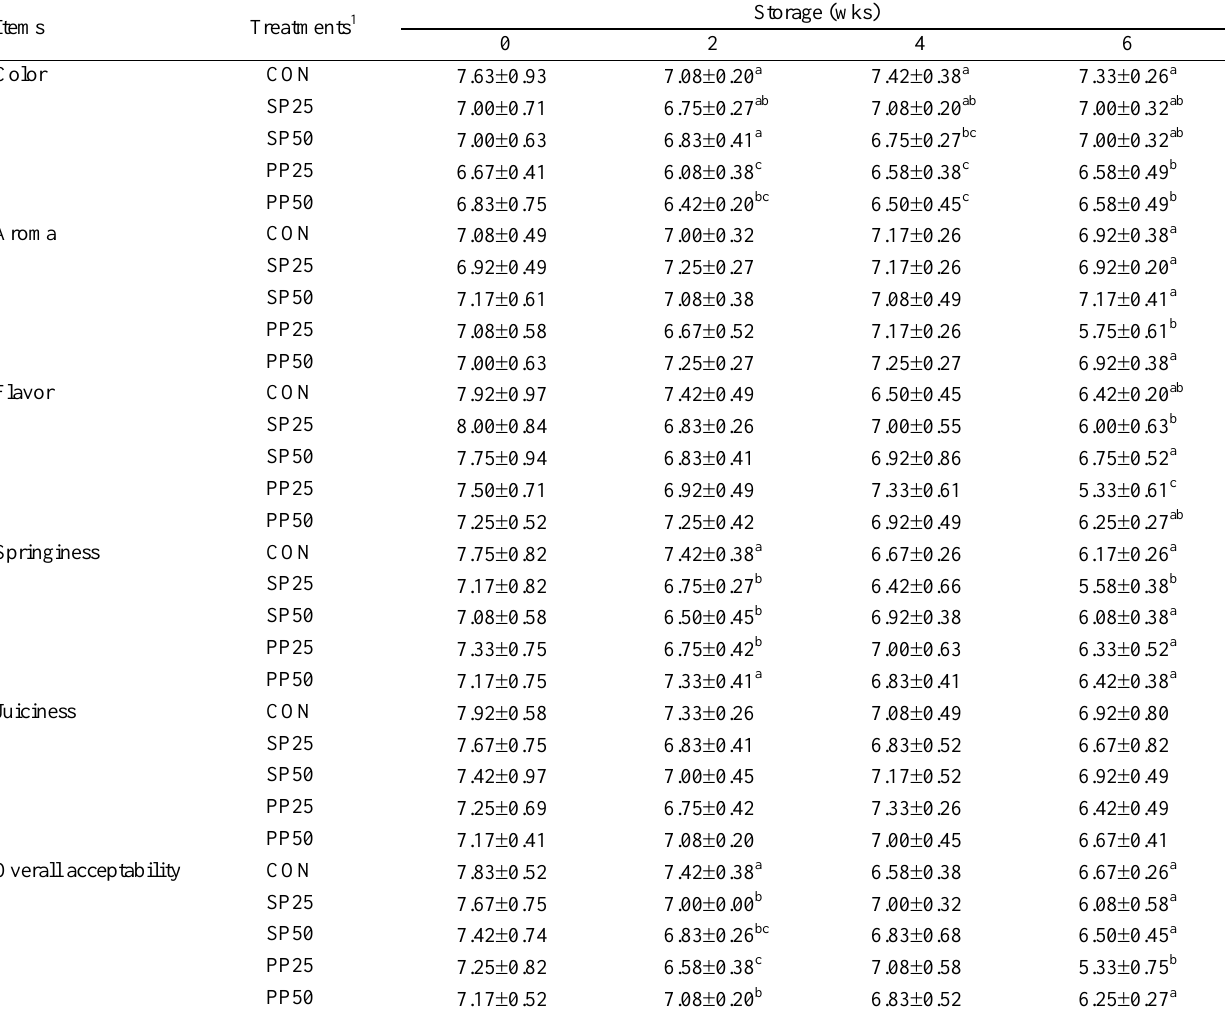
Table 6. Sensory evaluation of cooked pork sausages containing two different percentages of purple sweet potato combined with nitrite during 6 wks of storage at 4 